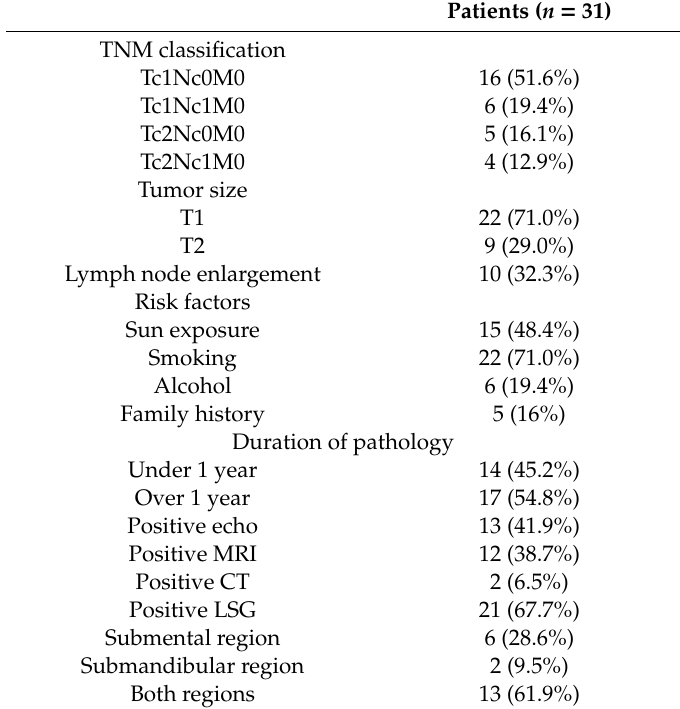
Table 2. The characteristics of squamous cell carcinoma (SCC) of the lower lip and diagnostic procedure findings.